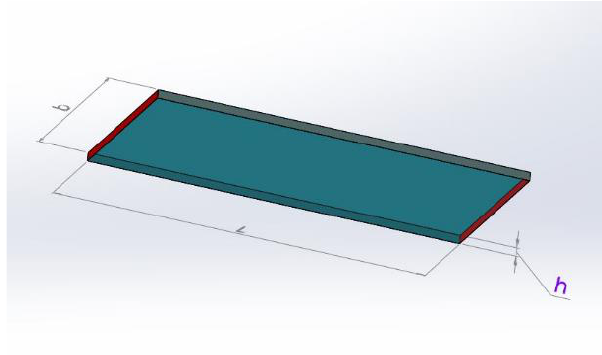
Figure 9. Representative volume of Joule effect model.